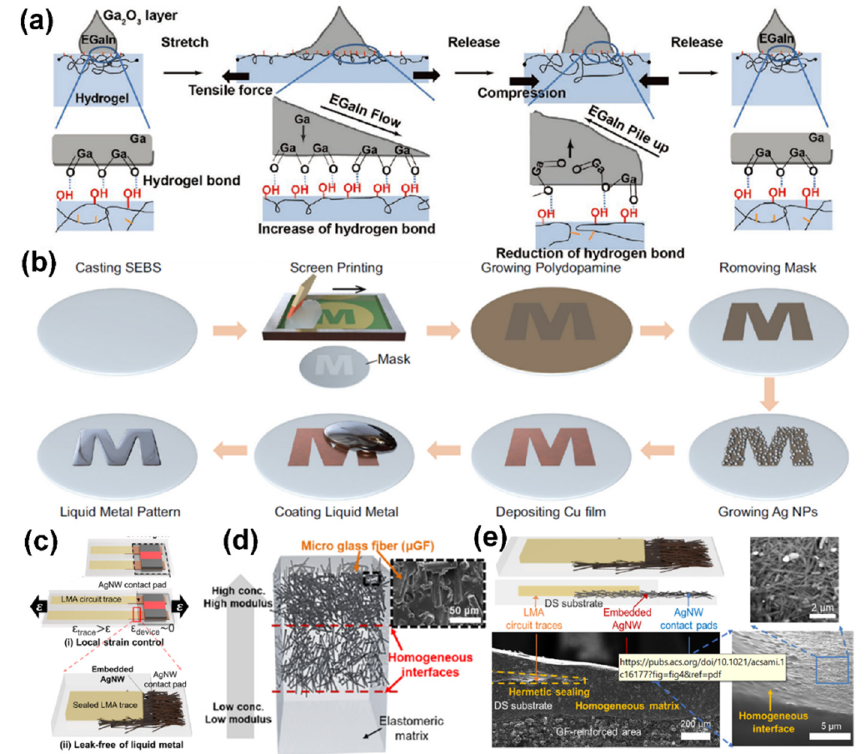
Figure 6. The selected printing of LM-based nano-composites. ( a ) Photographs and illustrations of LM droplets’ surface reconciliation on hydrogel during stretching and releasing. Reprinted with permission from Ref. [87] Copyright 2020 John Wiley and Sons. ( b ) The process to create a specific LM pattern on elastomer. Reprinted with permission from Ref. [35] Copyright 2021 Springer Nature. ( c ) Unit structure of the LM-based circuit including two design strategies for reliability enhancement. ( d ) The homogeneous interfaces between the matrices with different elastic moduli. ( e ) The leak-free structure of embedded AgNW networks. Reprinted with permission from Ref. [88] Copyright 2022 American Chemical Society.